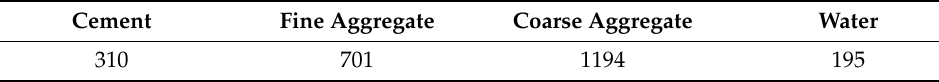
Table 1. The mix proportion for per cubic meter concrete (kg). Cement Fine Aggregate Coarse Aggregate Water 310 701 1194